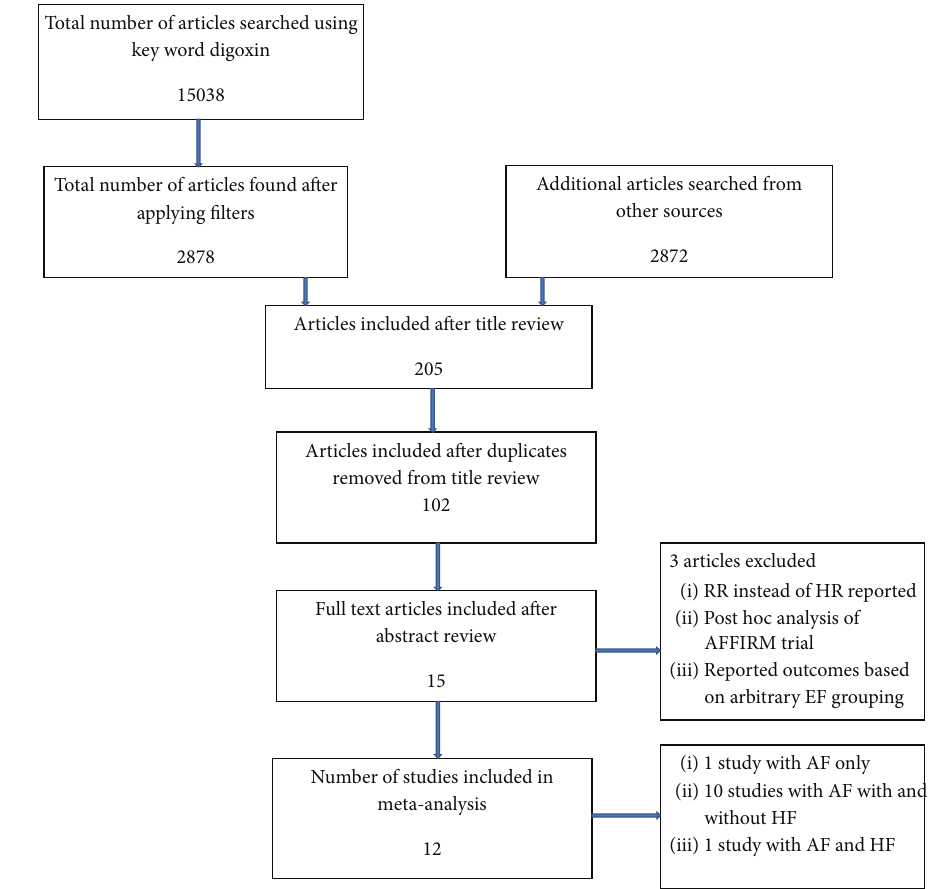
Figure 1: Prisma flow diagram for study